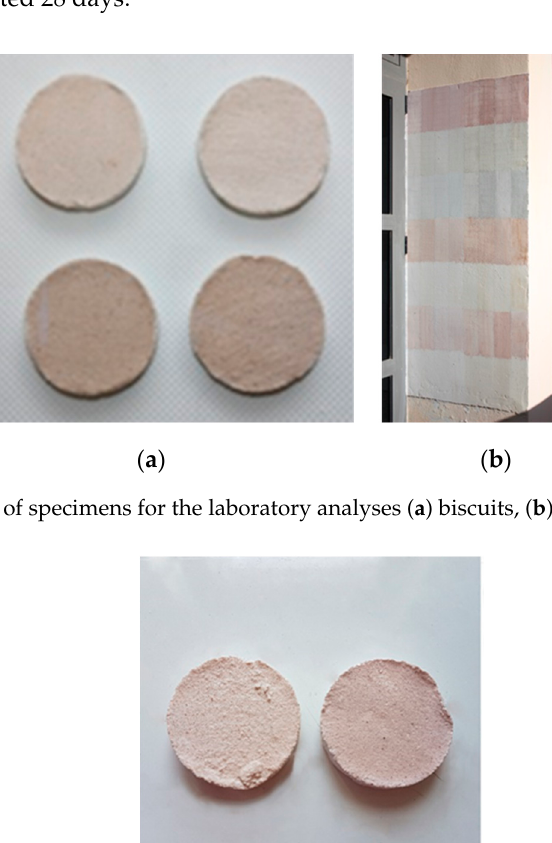
Figure 4. Specimens used for the UV test.